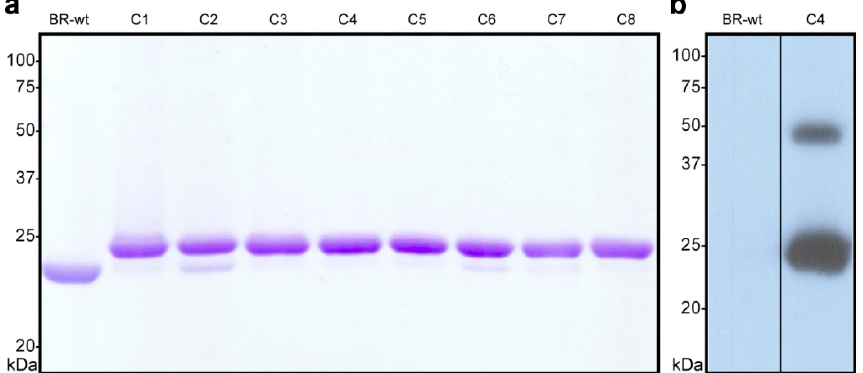
Figure 3. Analysis of BR-C-His 10 clones by SDS-PAGE and Western blot. ( a ) Coomassie Brilliant blue-stained 13.5% SDS/polyacrylamide gel of isolated purple membranes from H. salinarum L33 clones transformed with BR-C-His 10 (C1–C8) and BR-wt (isolated from H. salinarum S9) as a control. BR-C-His 10 migrates slower compared to BR-wt because of the additional His 10 -tag. In each lane purple membranes corresponding to 5 µg of bacteriorhodopsin were loaded. ( b ) Western blot analysis of BR-wt and BR-C-His 10 (C4) performed using an SDS gel run under similar conditions as in ( a ). The primary and secondary antibodies used were mouse monoclonal anti-penta-His antibody (dilution 1:3000) and horseradish peroxidase-conjugated goat anti-mouse antibody (dilution 1:3000), respectively. BR-wt showed no band, due to the absence of a His 10 -tag. BR-C-His 10 reacted with the anti-penta-His antibody, confirming the presence of the introduced His 10 -tag. A weaker band around 50 kDa indicates the presence of SDS-resistant BR-C-His 10